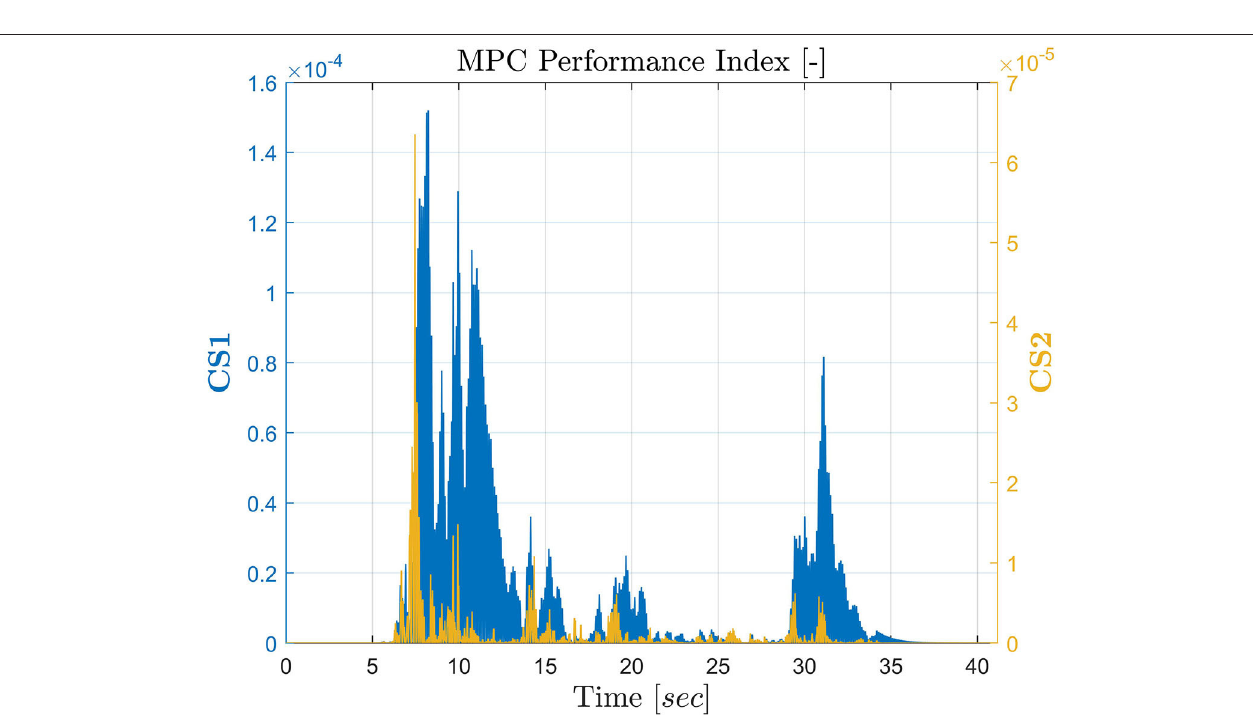
FIGURE 8 | Displacement responses of the reference model and of the numerical and physical vRTHS substructures in CS1.